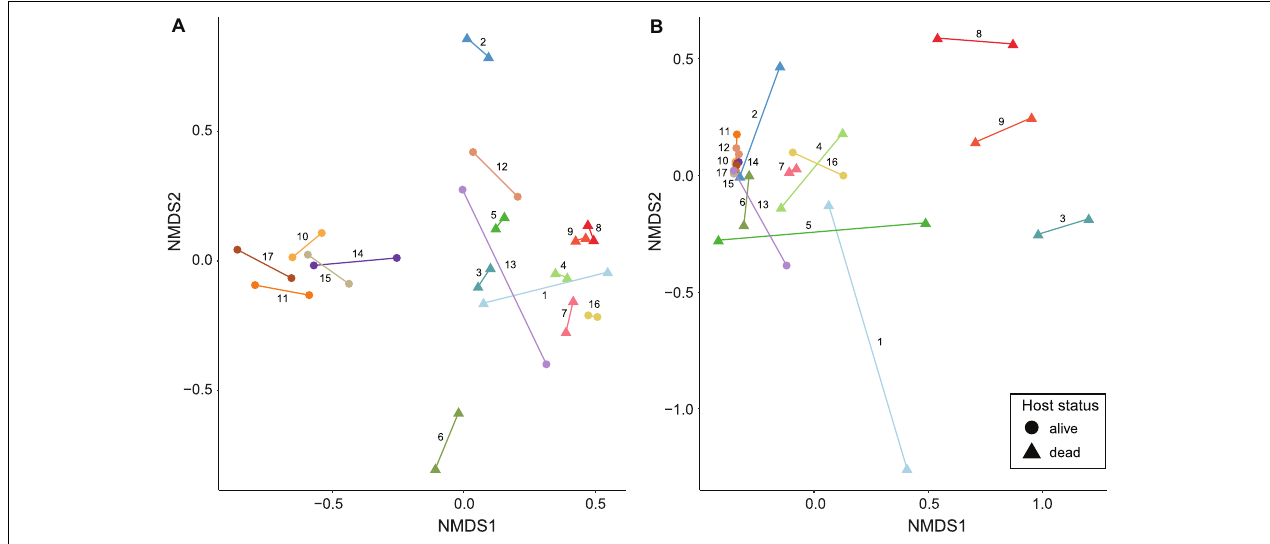
FIGURE 3 | NMDS ordinations of seal louse microbiomes based on Bray–Curtis dissimilarity matrices. (A) MAG matrix (stress = 0.132), and (B) Kaiju matrix (species level, stress = 0.081). Lice originating from the same seal individual are colored similarly and connected by a line, numbers next to lines refer to seal individuals in Figures 1 , 2 . TABLE 2 | PERMANOVA results from the factors in addition to infrapopulation that were evaluated to potentially influence microbiome variation among samples. Data